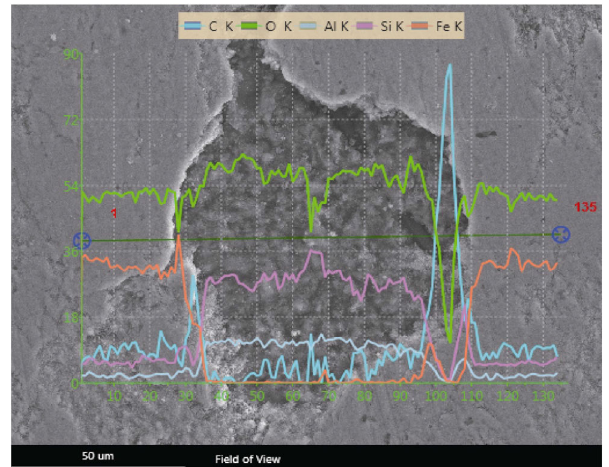
Fig. 7 EDS analysis of the worn surface of 37%C f /LAS